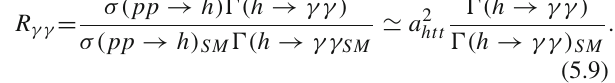
Table 7 Numerical values for the deviation factors a htt , a hWW and a hW (cid:2) W (cid:2) used for the computation of the Higgs diphoton decay rate. Here we set v χ = 10